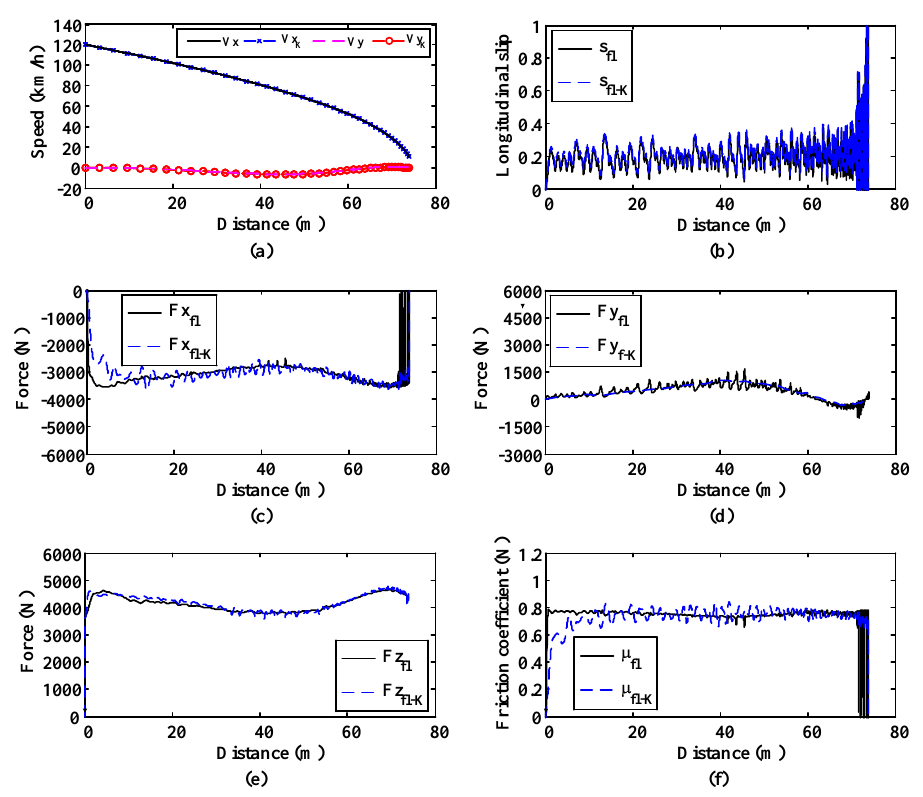
Figure 12. Curve simulation. Surface µ = 0.8. 500 m. radius curve. ( a ) Longitudinal and lateral speed; ( b ) Longitudinal slip; ( c ) Longitudinal forces; ( d ) Lateral forces; ( e ) Vertical forces; ( f ) Friction coefficient.